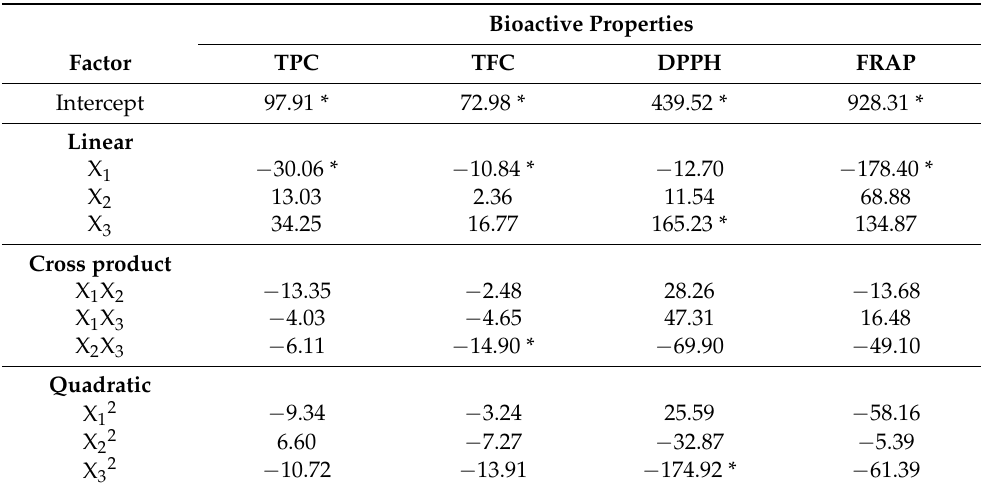
Table 4. Regression coefficient of the predicted second-order polynomial models (BBD) for bio- active